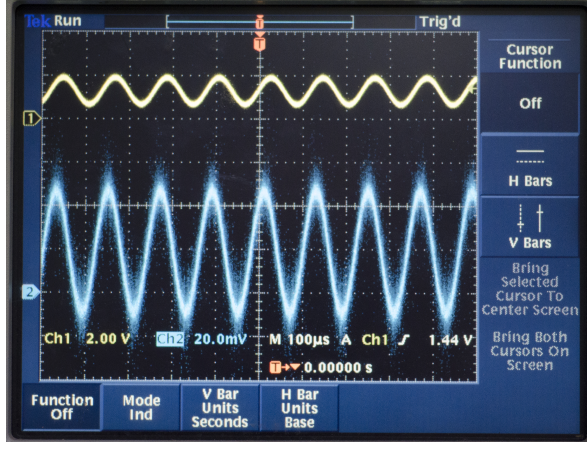
Figure 25. The output of the detecting components.